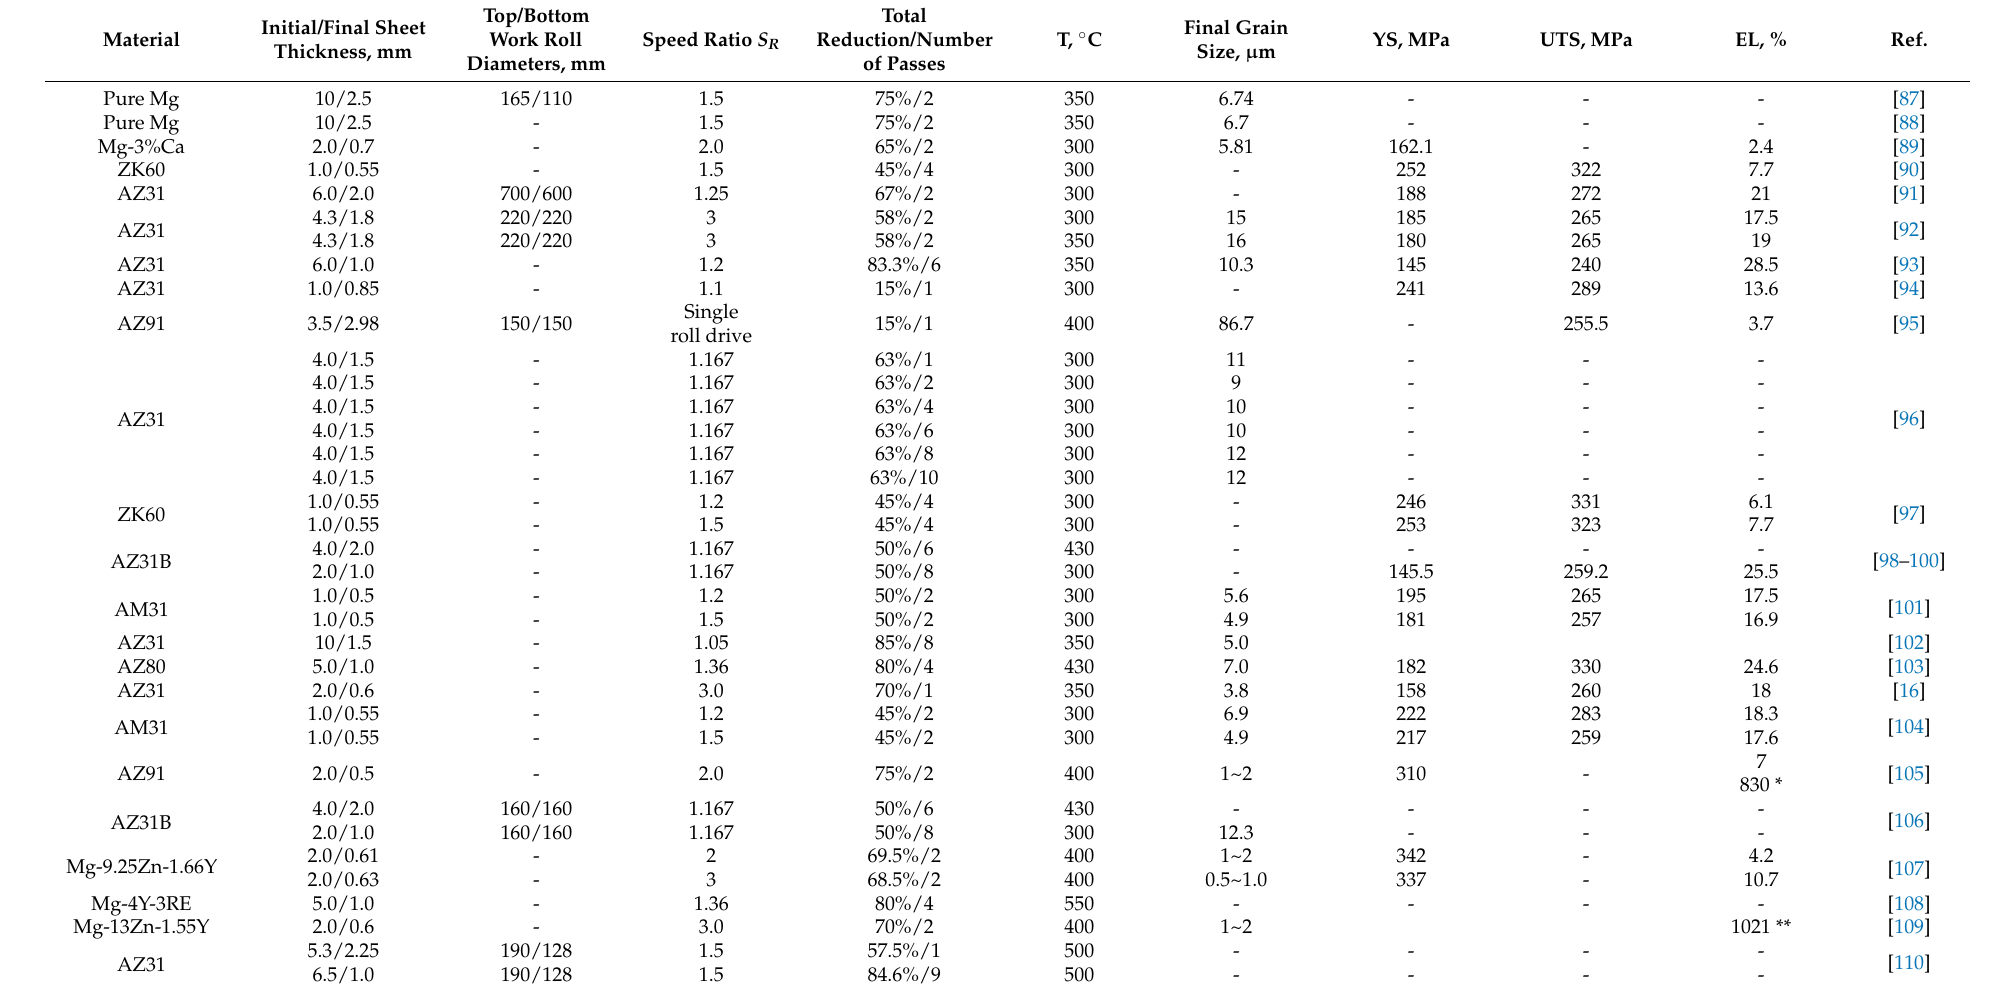
Table 2. Experimental data related to asymmetric hot rolling of Mg